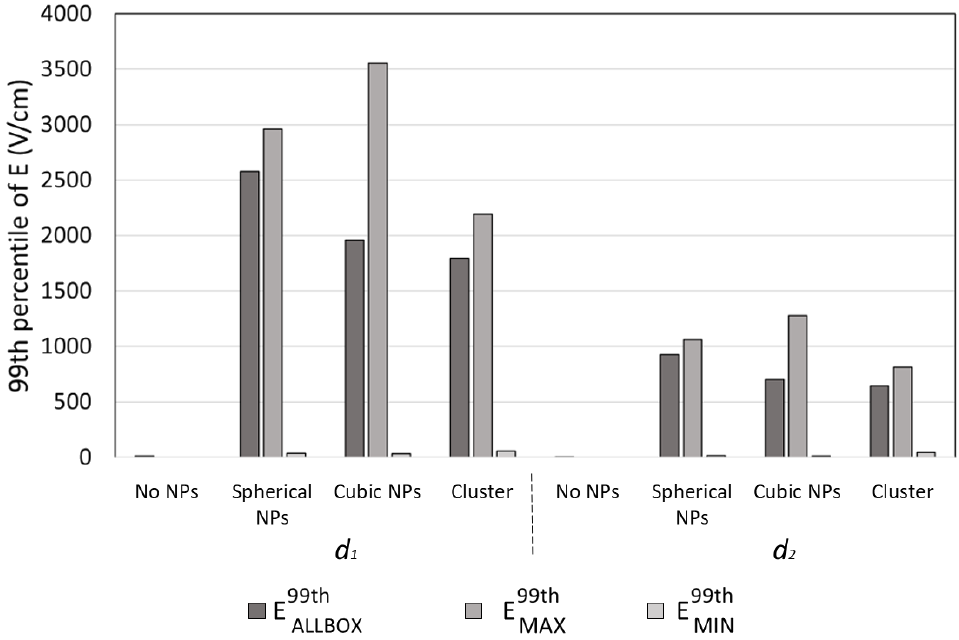
Figure 3. E 99th AllBox , E 99th MAX , and E 99th MIN at distances d 1 = 0.05 mm and d 2 = 0.2 mm from Figure 3. E 99thAllBox , E 99thMAX , and E 99thMIN at distances d 1 = 0.05 mm and d 2 = 0.2 mm from the coil for the three different Au NP configurations considered, and, for a comparison, when no Au NP was considered.